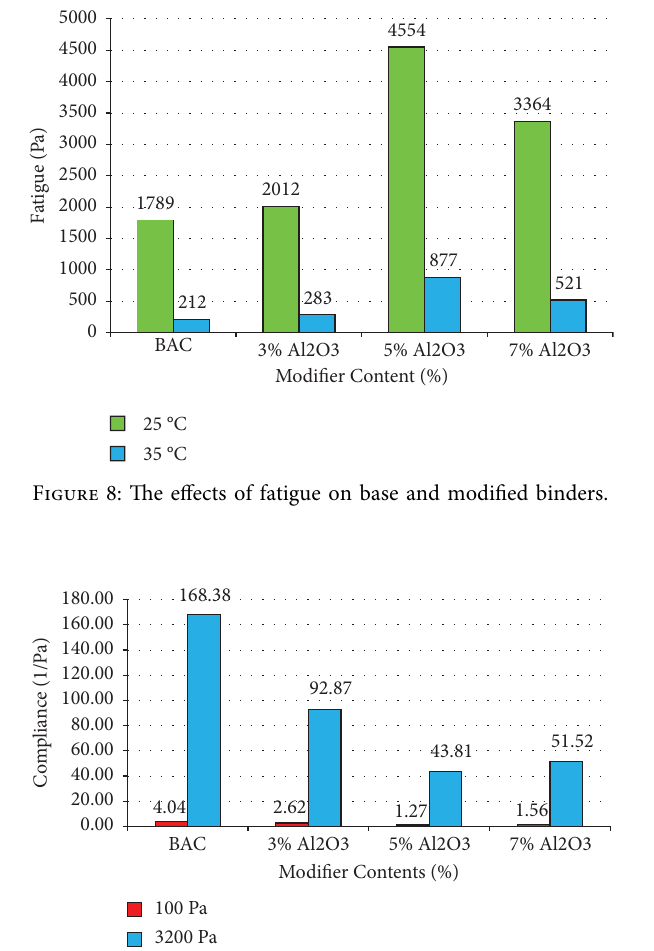
Figure 9: MSCR for the base and modifed asphalt binders under stress levels of 100 and